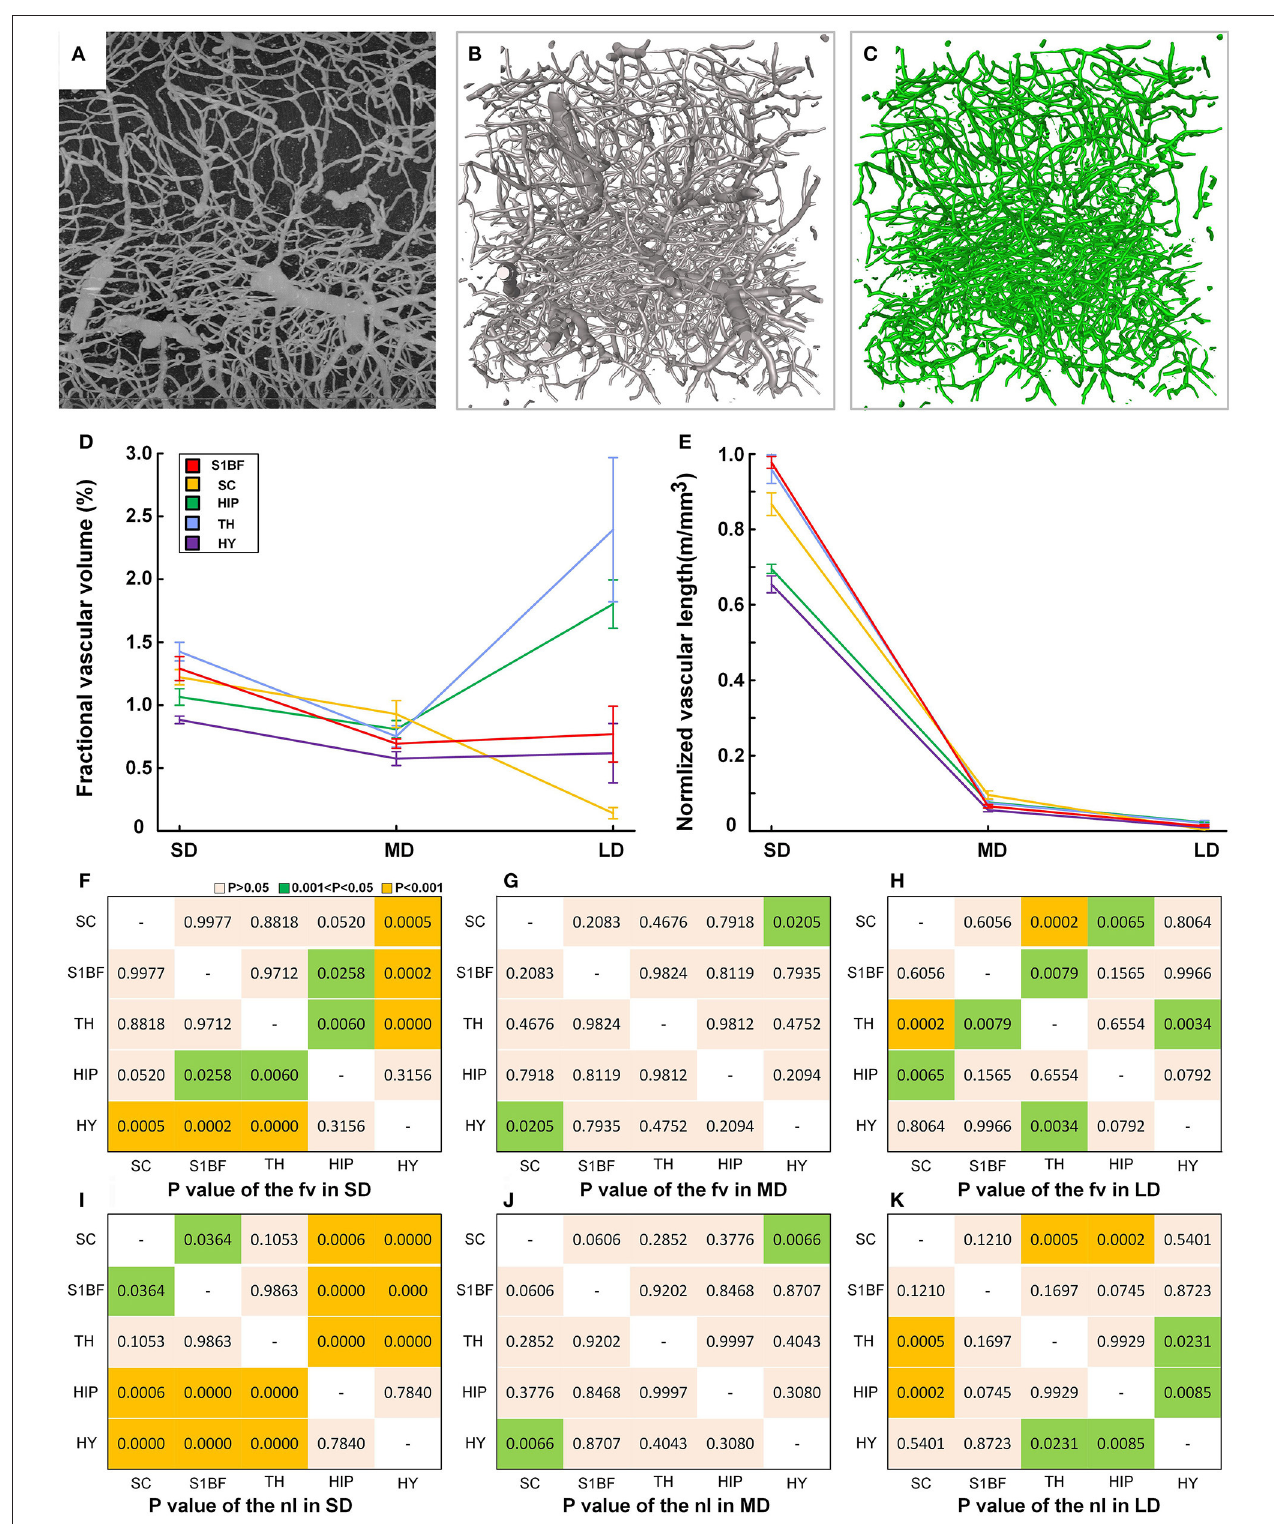
FIGURE 9 | Quantitative statistical results for the capillary density in the cortical and subcortical areas of the mouse brain. (A) Maximum projection of 200 µ m to show the vessels in HIP (image size of 400 400 µ m). (B) The reconstructed fine vascular network in HIP (stack size of 400 ×